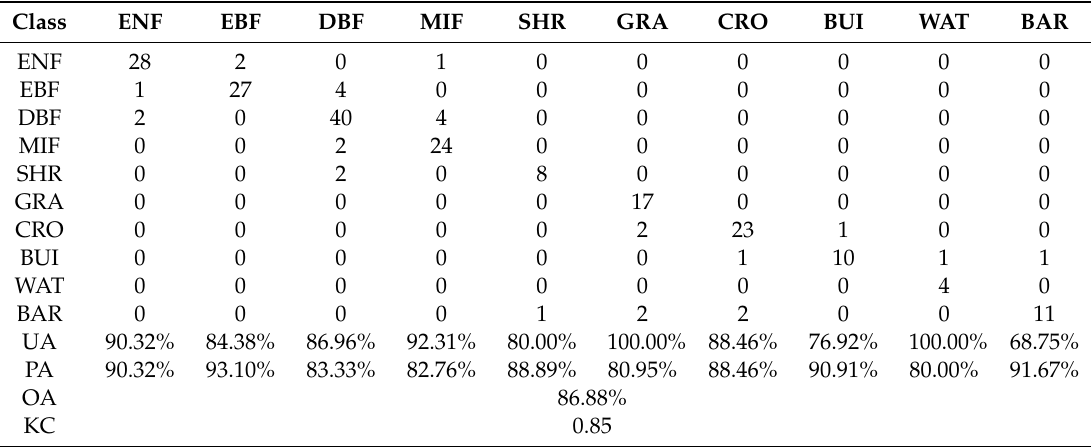
Table 4. Confusion matrix for land cover